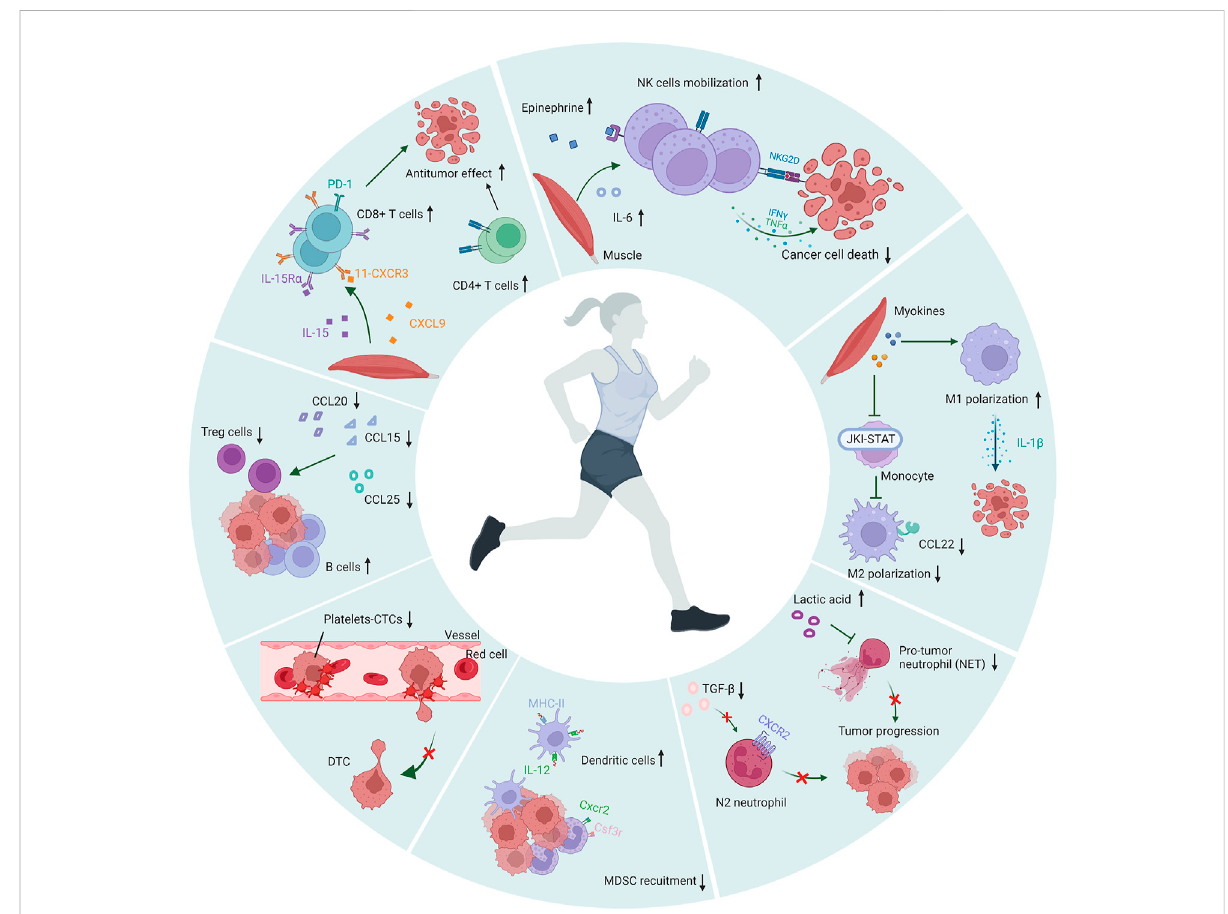
Modulation of immune cells during exercise. During physical activity, the numbers and antitumor effects of NK cells, dendritic cells, T cells and Bcellswereincreased,thepolarizationofM2macrophagesandN2neutrophilsareinhibited,andtherecruitmentofMDSCandTregwassuppressed. Moreover, PA inhibited the formation of platelet-CTCs aggregates and reduced the adhesion of platelets to endothelial cells. The fi gure was created with